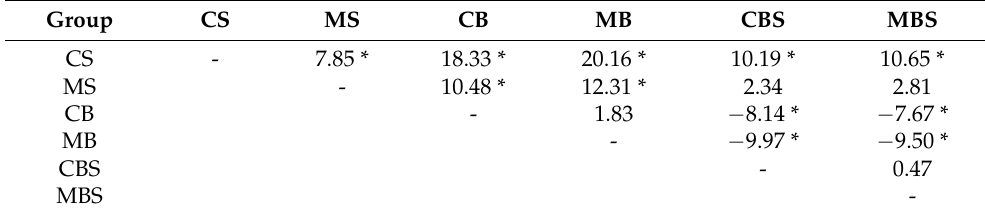
Table 2. Mean differences of shear bond strengths of each group (MPa). Group CS